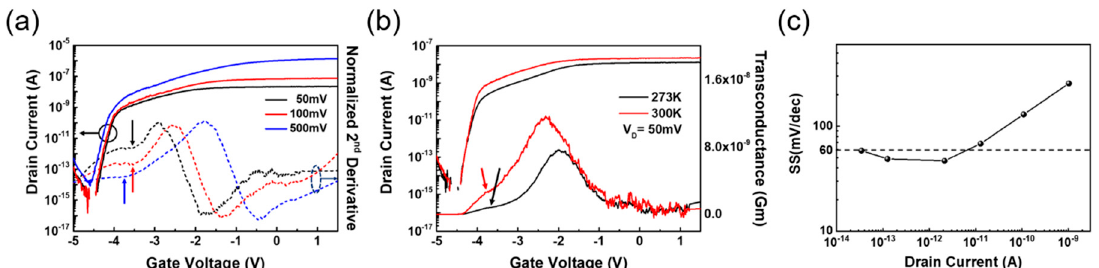
Figure 4. ( a ) Transfer characteristics of a MoS 2 /BP heterojunction FET for different drain voltages (50 mV, 100 mV, and 500 mV). Normalized second derivative of transfer curves are shown to note the initiation points of band-to-band tunneling (BTBT). ( b ) Temperature-dependent transfer characteristic at 273 and 300 K, V D = 50 mV. ( c ) Subthreshold swing (SS) versus drain current at V D = 500 mV, 300 K.